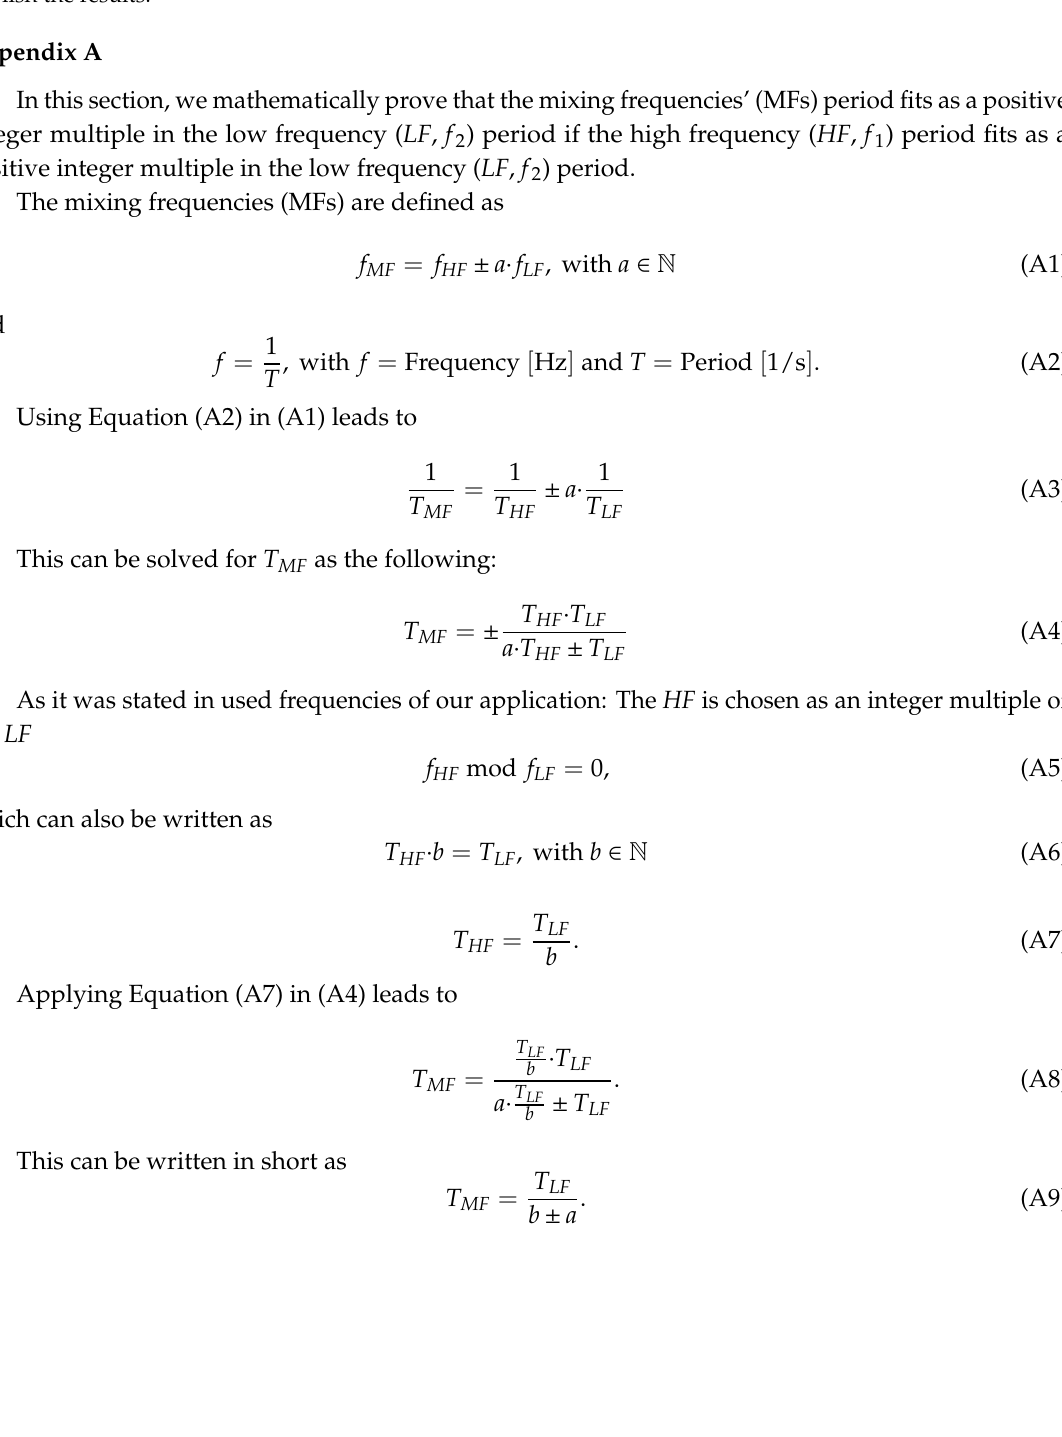
s1, Figure S1: Measured amplitude as a function of excitation frequency f 1 of 1 µ mSynomagD fixed in